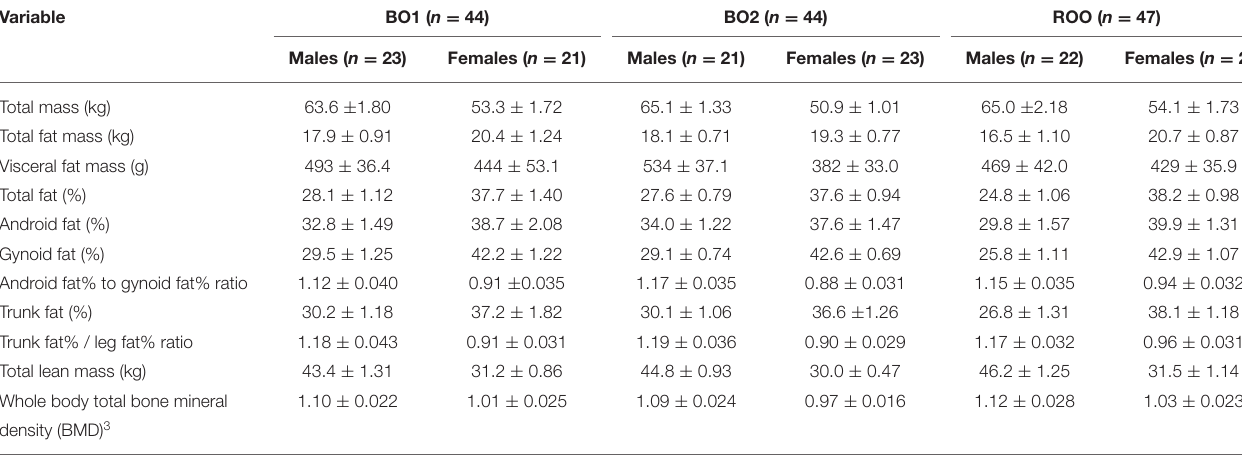
TABLE 1 | Baseline body composition measurements obtained using DXA of the participants randomized into the three intervention groups, namely, BO1, BO2, and ROO, presented as mean ± standard error of the mean. Variable